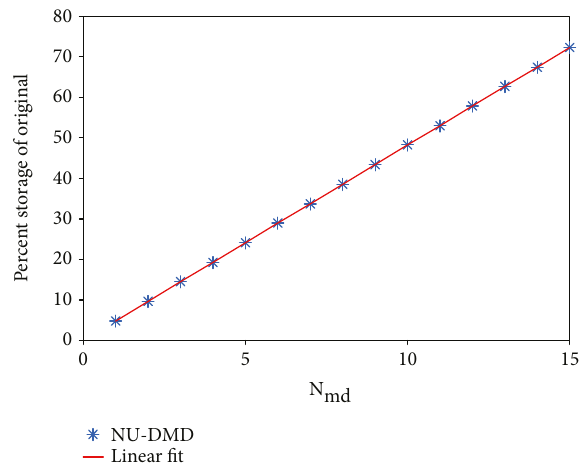
Figure 2: Percent memory vs. N